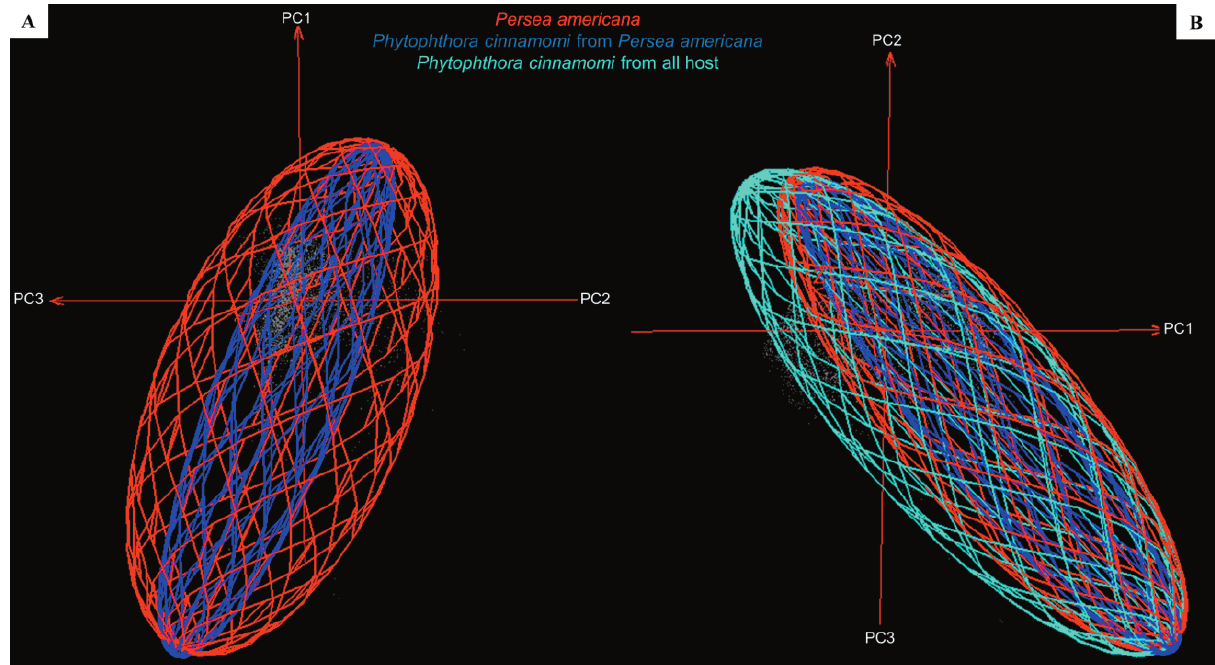
Figure 3. Environmental space of Persea americana , Phytophthora cinnamomi from P. americana (A), and P. cinnamomi from different hosts (B), modeled in NicheA. Ecological niche models based on a model of minimum-volume ellipsoids and visualization in three dimensions associated with principal component of bio-variables (Table 1). PC: principal components.